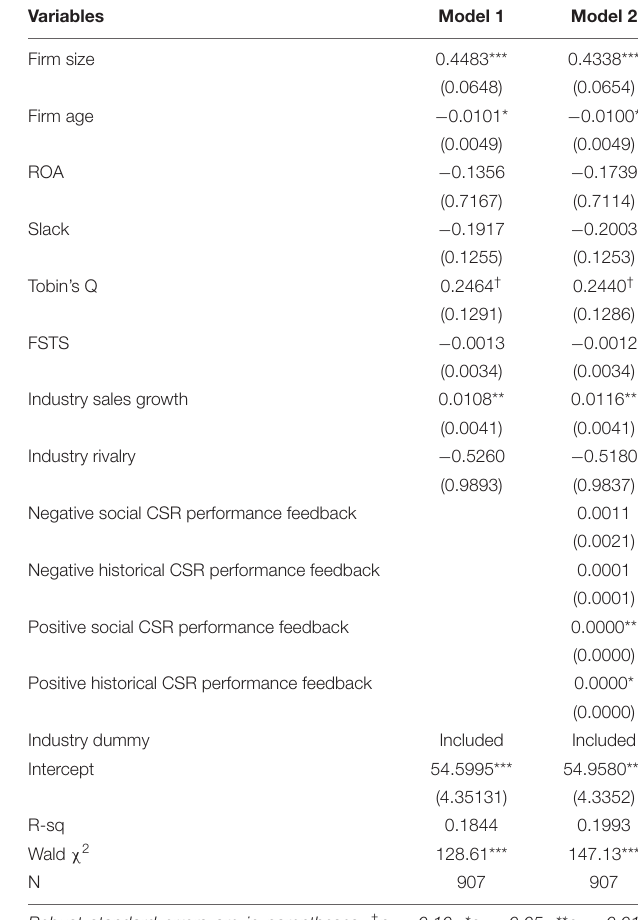
TABLE 2 | Random effects GLS model (full sample). TABLE 3 | Random effects GLS model (manufacturing